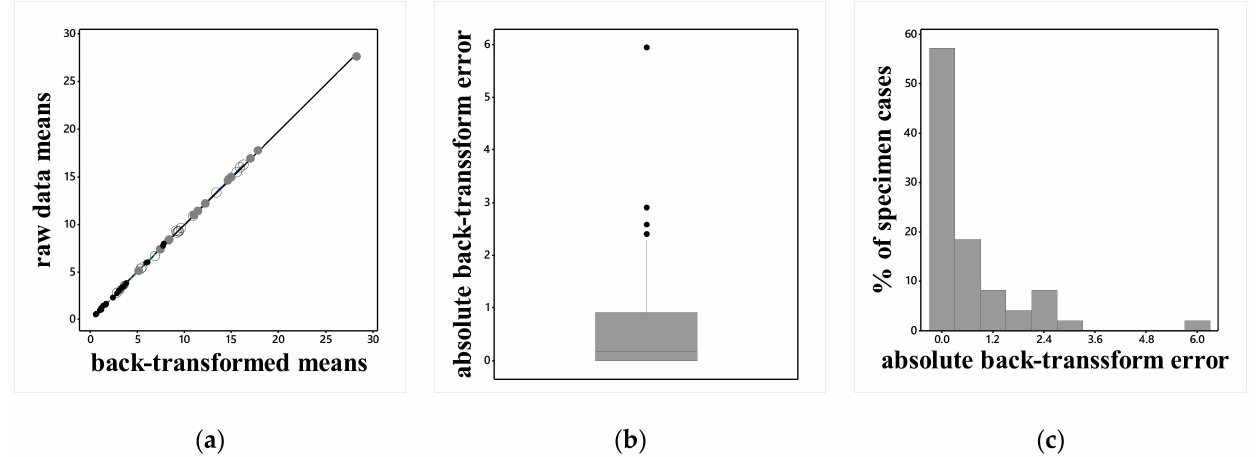
Figure 3. Specimen absolute error percentage visualizations: % error = |raw—back- transformed|/raw (gray solid denotes Table 5 DFW%, open circles denote Table 5 DC%, and solid black circles denote Table 5 DC density entries). Left ( a ): scatterplot portrayal of the relationship between the raw and back-transformed arithmetic means. Middle ( b ): boxplot of the percent absolute error. Right ( c ): histogram of the percent absolute